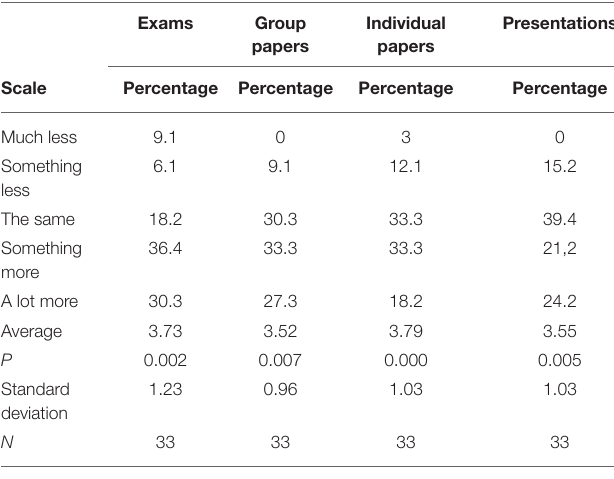
TABLE 3 | Comparison of the learning sensation with other grading ways and competitive debate.